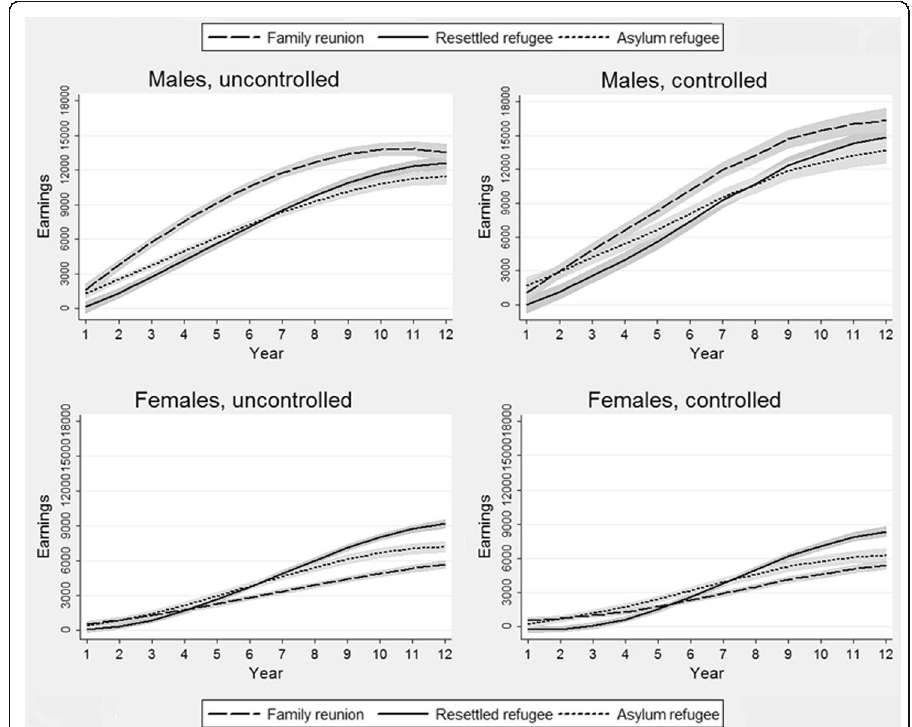
Fig. 2 The predicted annual earnings (EUR), including zeros, by admission category and duration of stay among individuals aged 25 – 60. Notes: All earnings have been calibrated to the level of 2015 according to the index of wage and salary earnings (Statistics Finland 2019b). Controls are held at means in particular year of residence. Robust 95% confidence intervals. See Table 3 in Appendix for regression coefficients